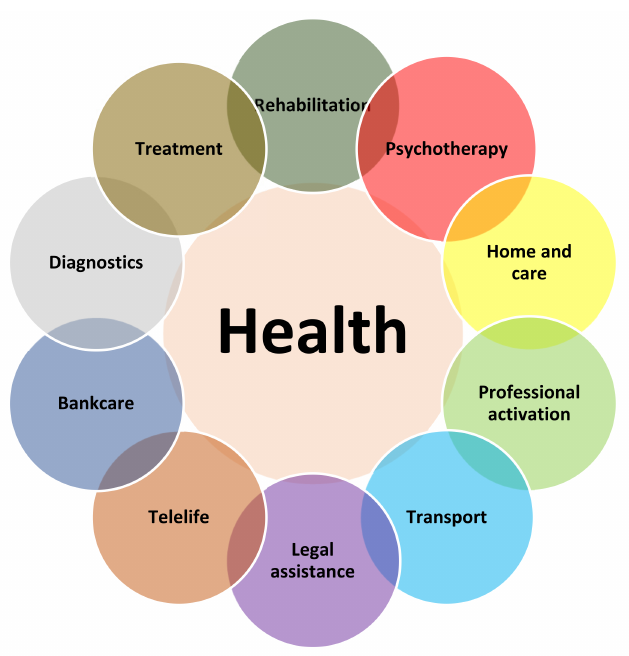
Figure 1. The model of health reconstruction procedure—own